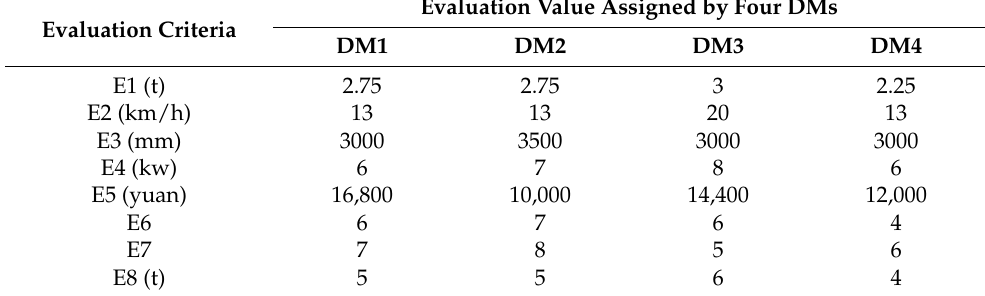
(b) Scheme Value Assessment of Evaluation Criteria on the Economy Evaluation Criteria